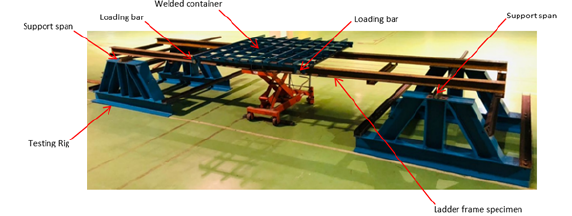
Fig. 11. Test Rig setup for